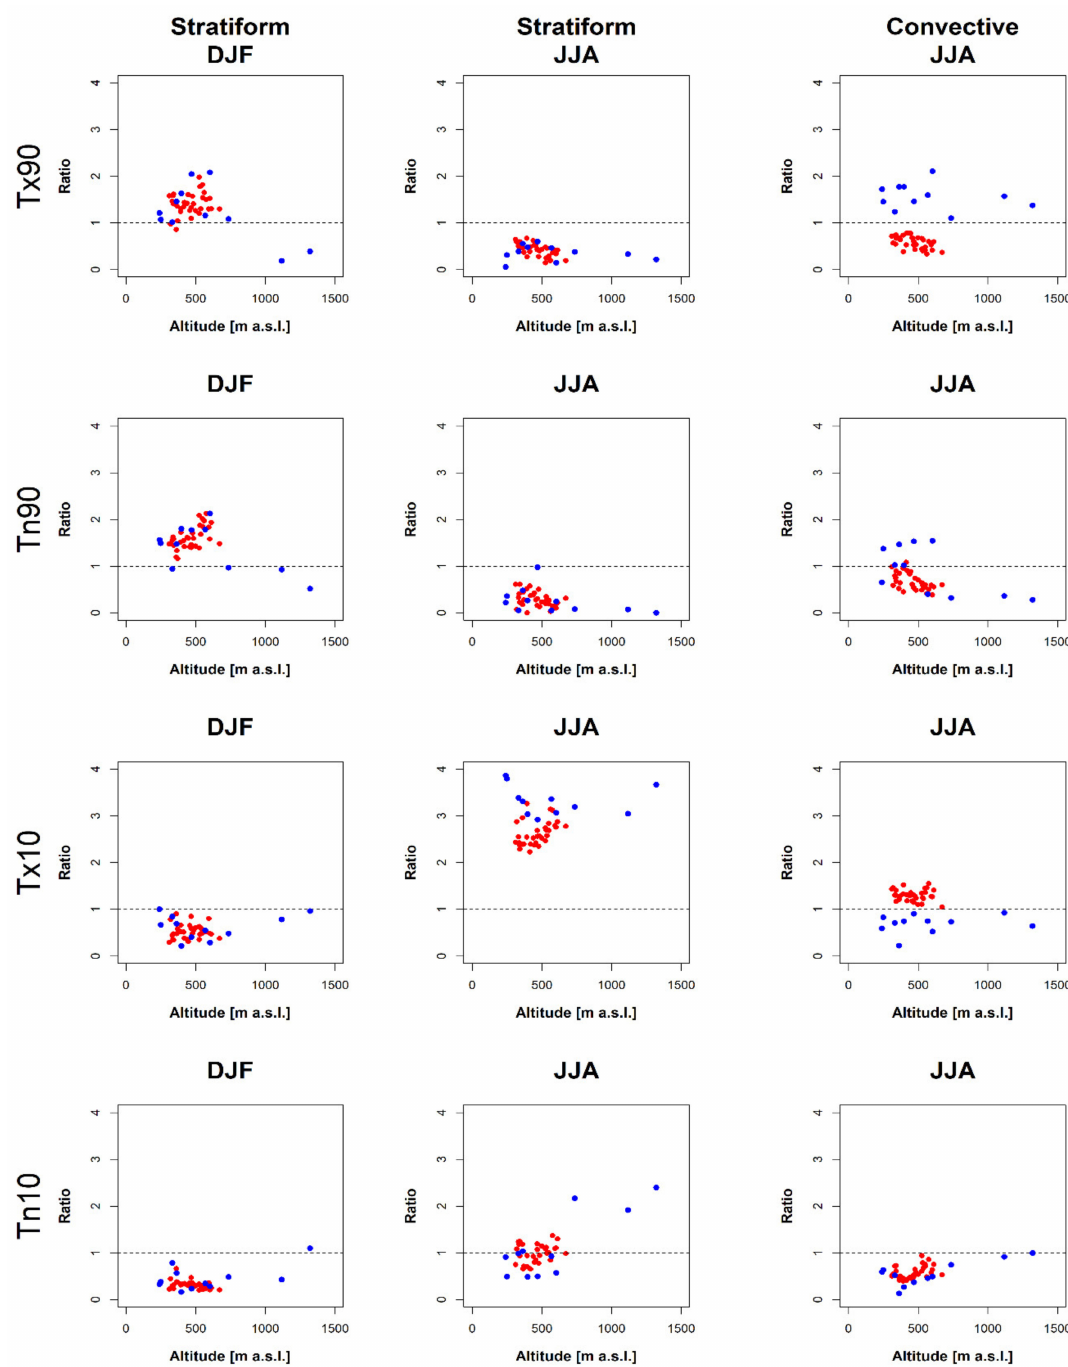
Figure 3. Dependence between the geographical altitude and the frequency of extreme temperature events occurring simultaneously with heavy precipitation events for stratiform (1st and 2nd columns) or convective (3rd column) precipitation in winter and summer, expressed as ratios to the expected value (to the unconditional frequency of the given kind notable precipitation in the given season). Blue points depict data for each station, while red points depict data for ERA-Interim